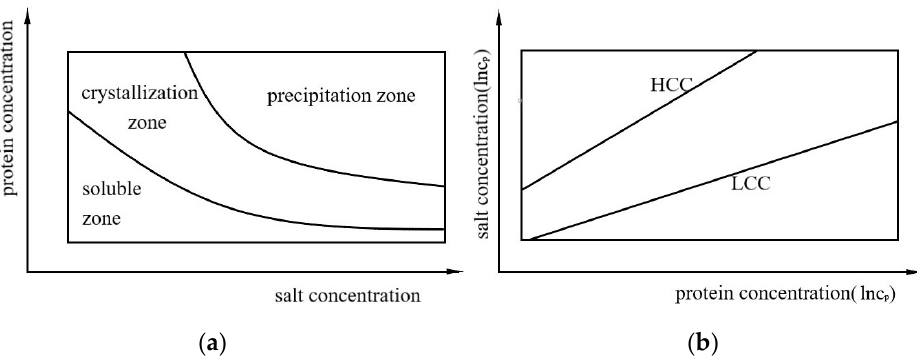
Figure 1. ( a ) A simple model of a phase diagram. ( b ) The reentrant condensation (RC) of a